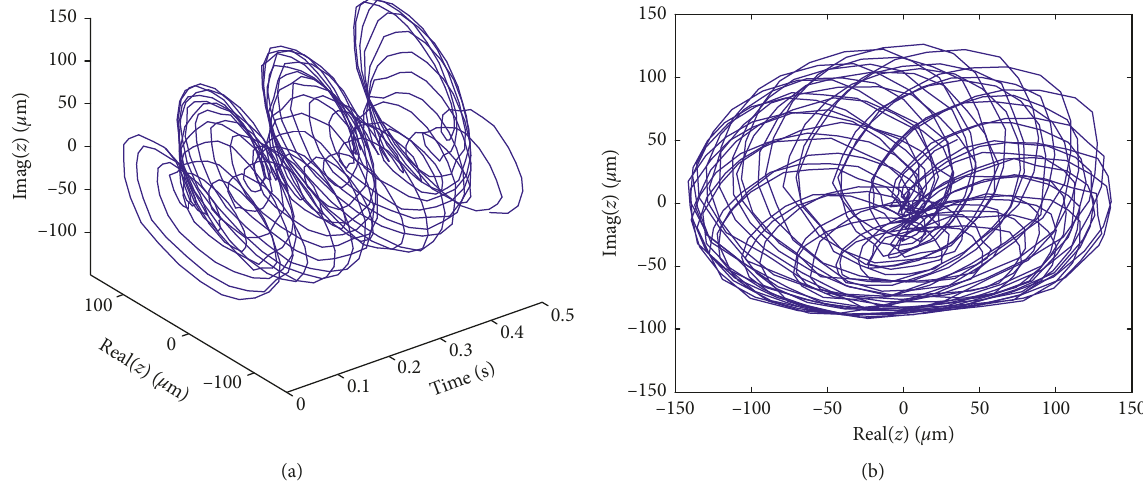
Figure 5: The oil film oscillation signal of z : (a) the three-dimensional time-domain waveform; (b) the two-dimensional plots.